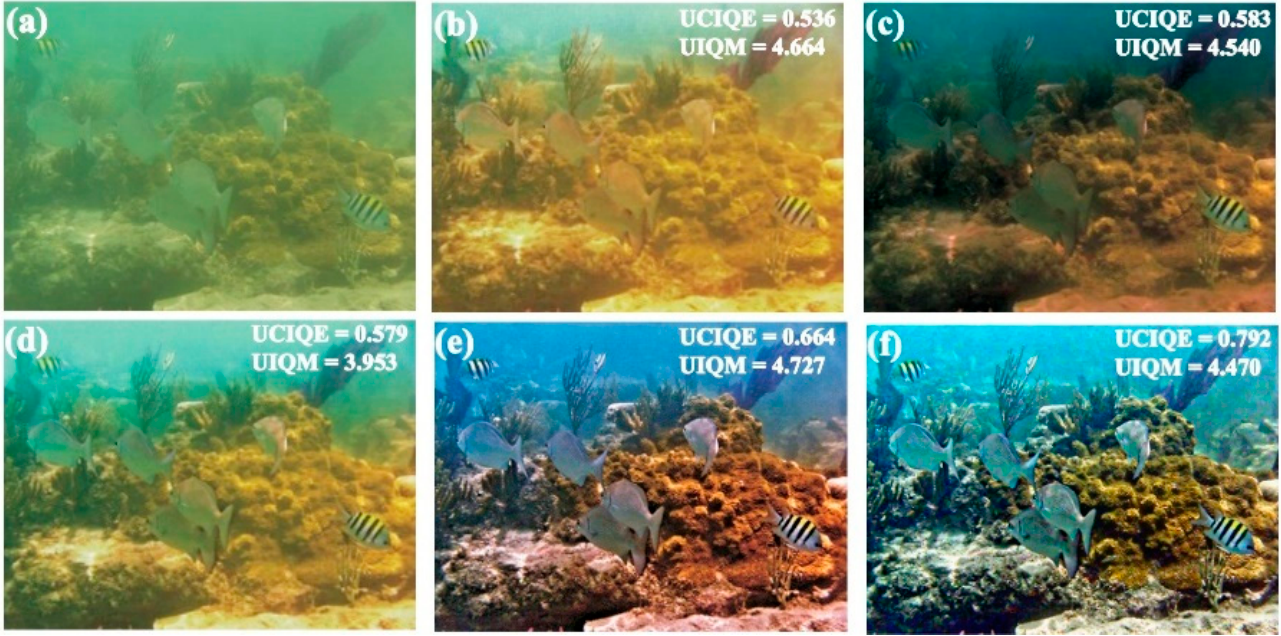
Figure 6. ( a ) Initial image, ( b ) Gibson et al. [33], ( c ) Fattal et al. [29], ( d ) Lu et al. [5], ( e ) Ancuti et al. [4], and ( f ) our method.